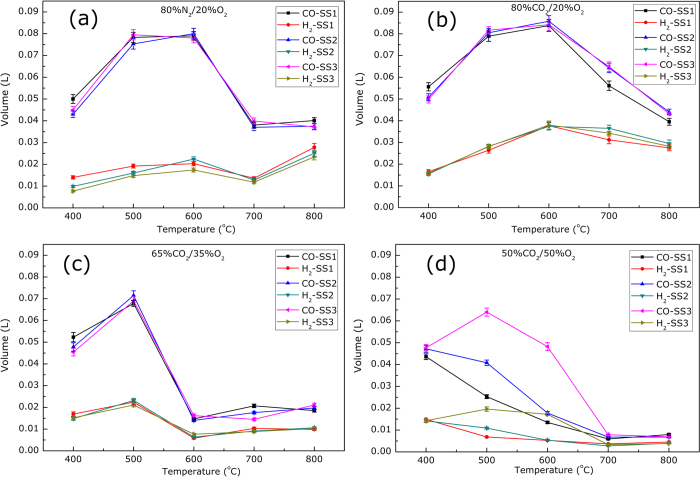
Major Gas yield in terms of temperature per gram of sludge for samples:(a) 80%N2/20%O2, (b) 80%CO2/20%O2, (c) 65CO2/35%O2 and (d) 50%CO2/50%O2.